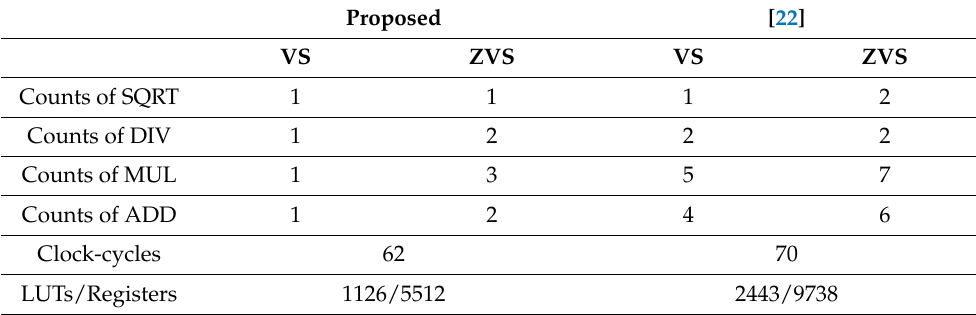
Table 4. Computing consumption of the proposed method and the method in [22].